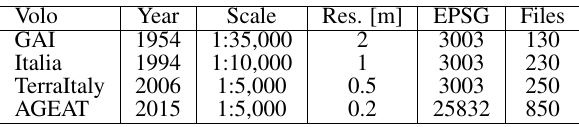
Table 2. Ortho-photos datasets main features. The “Res.” column refers to ground resolution.